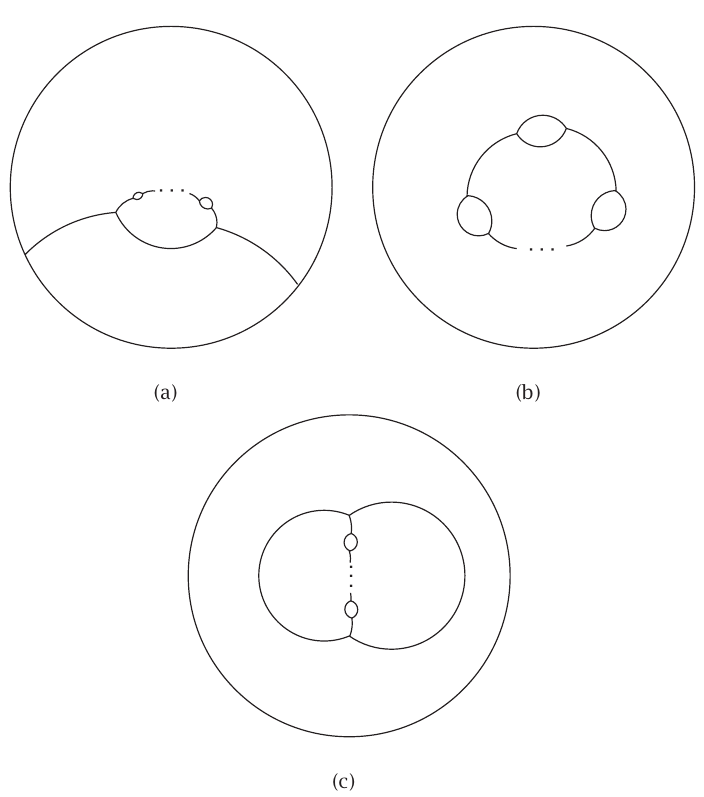
Figure 6.9 . The three cases of Corollary